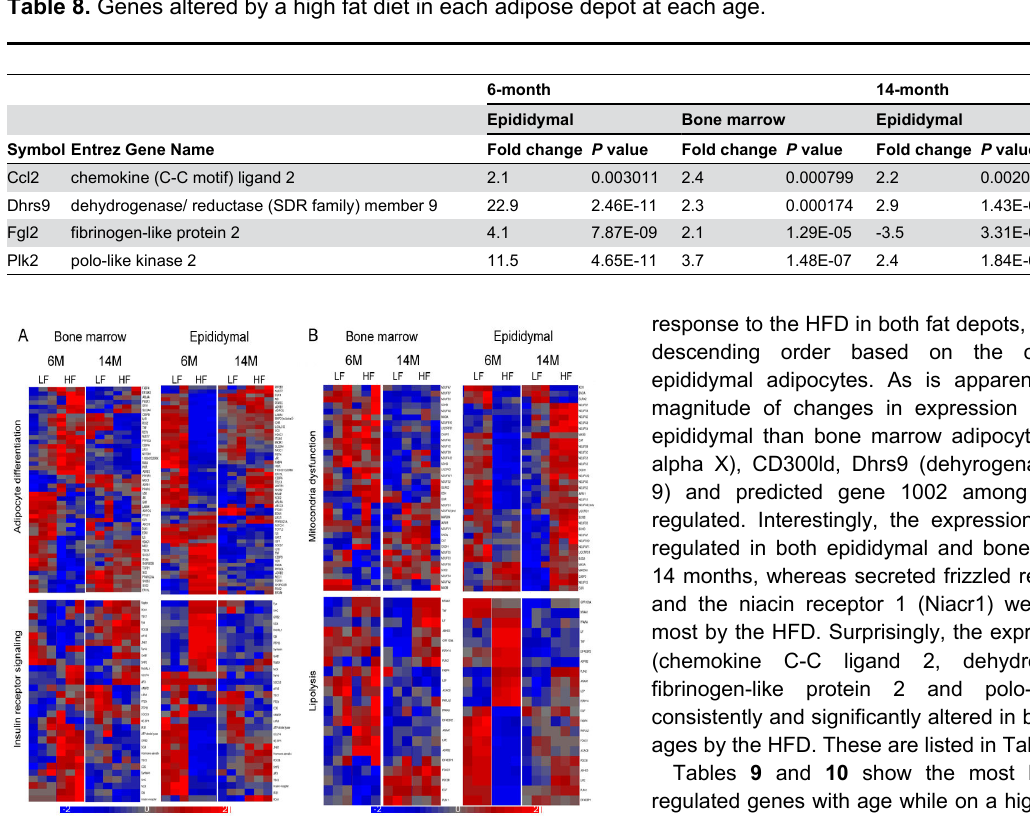
Figure 3. Heat maps of adipocyte-specific pathways in high fat diet. (a) Clustering of genes involved in adipocyte differentiation (upper panel) and insulin receptor signaling (lower panel) with at least a 2-fold difference between standard chow and high fat diet in bone marrow and epididymal adipocytes. (b) Clustering of genes involved in decreased transmembrane potential of mitochondria (upper panel) and lipolysis (lower panel) with at least a 2-fold difference between standard chow and high fat diet in bone marrow and epididymal adipocytes.